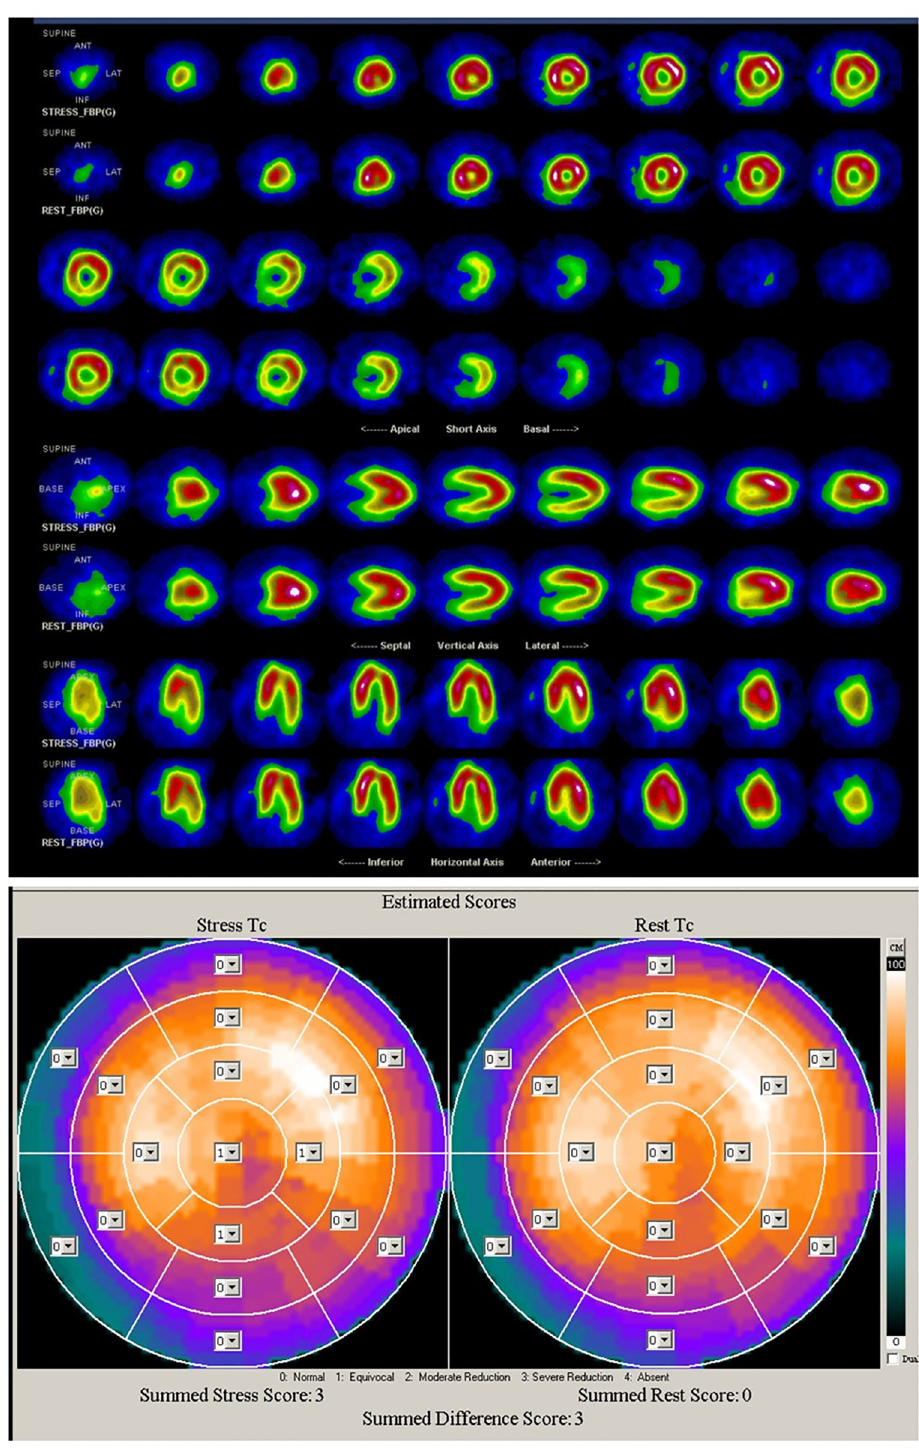
Fig 4. SPECT MPI results of GB0527. The rest and stress SPECT ischemia score of GB0527 are 0 and 3, respectively.